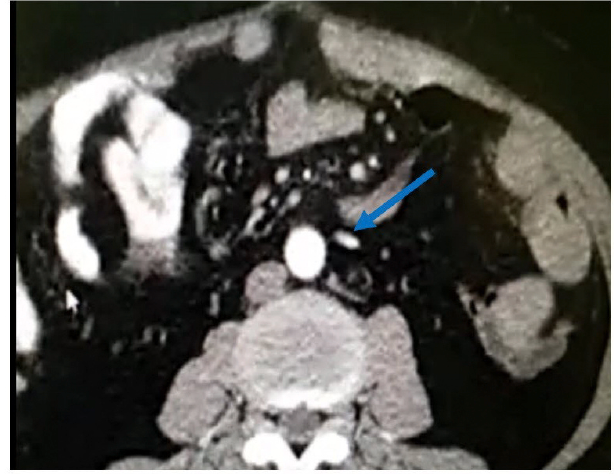
Figure 2. Abdominopelvic CT scan with IV contrast. Narrow enhancement of the inferior mesenteric artery can be observed (blue